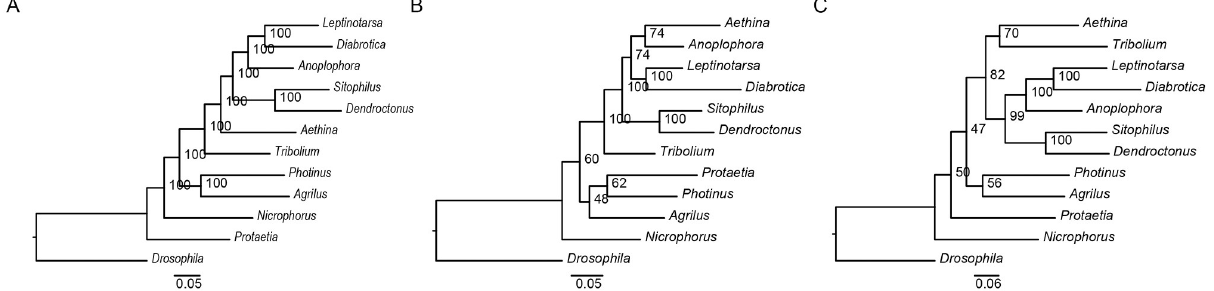
Fig 6. Genome comparison among representatives of coleoptera groups and coleoptera phylogeny. ( a ) 2,686,932 aa from 9,608 conserved orthologues, ( b ) 35,555 aa sites from 269 wing development orthologous, and ( c )1,952 aa sites from 19 metamorphosis orthologous. The tree was reconstructed by IQ-Tree 1.5.1 with the best fit model (LG+F+G4). The D. melanogaster was used as outgroups, Branch lengths were optimized and node ages were estimated from 100 trees.